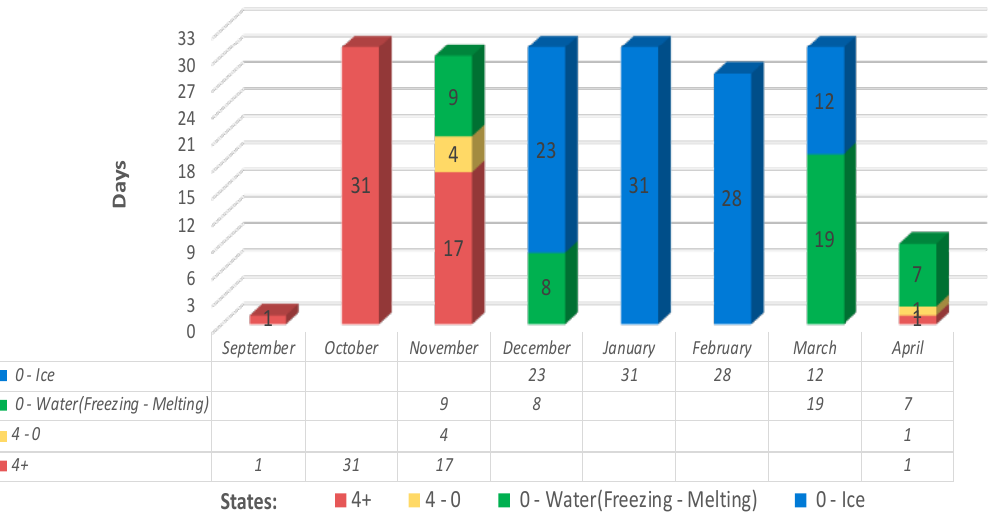
Figure 14. Ice storage states of t3—upper position.